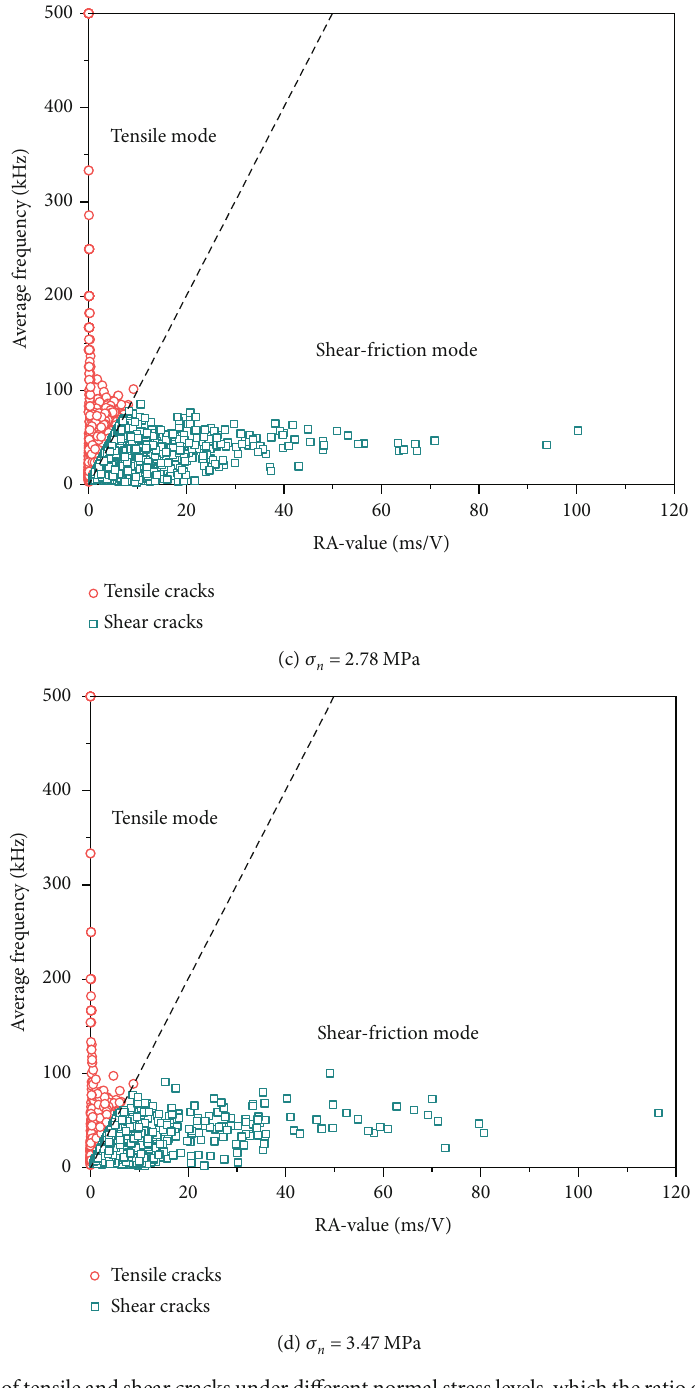
Figure 11: Signal distributions of tensile and shear cracks under di ff erent normal stress levels, which the ratio of the RA and the AF value is set to 1: